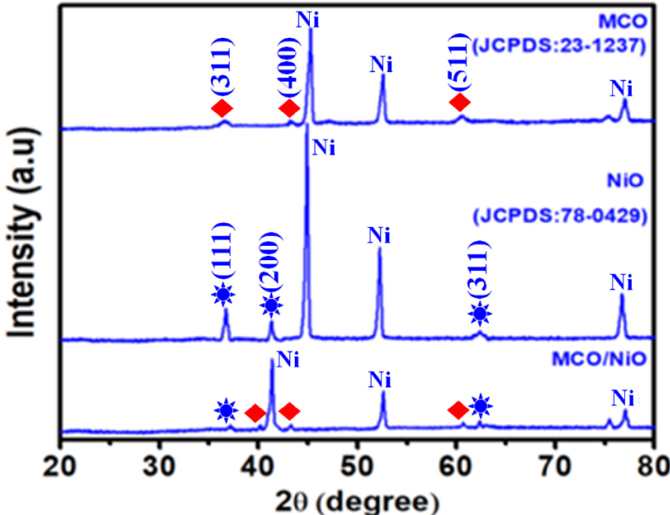
Figure 1. Powder X-ray diffraction pattern of the MCO, NiO, and MCO/NiO electrode materials deposited on Ni deposited on Ni foam.